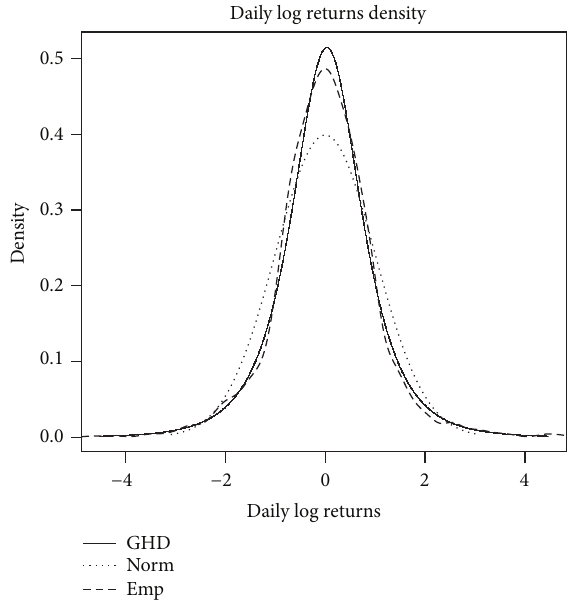
Figure 1: Empirical density of AGL versus fitted Normal and